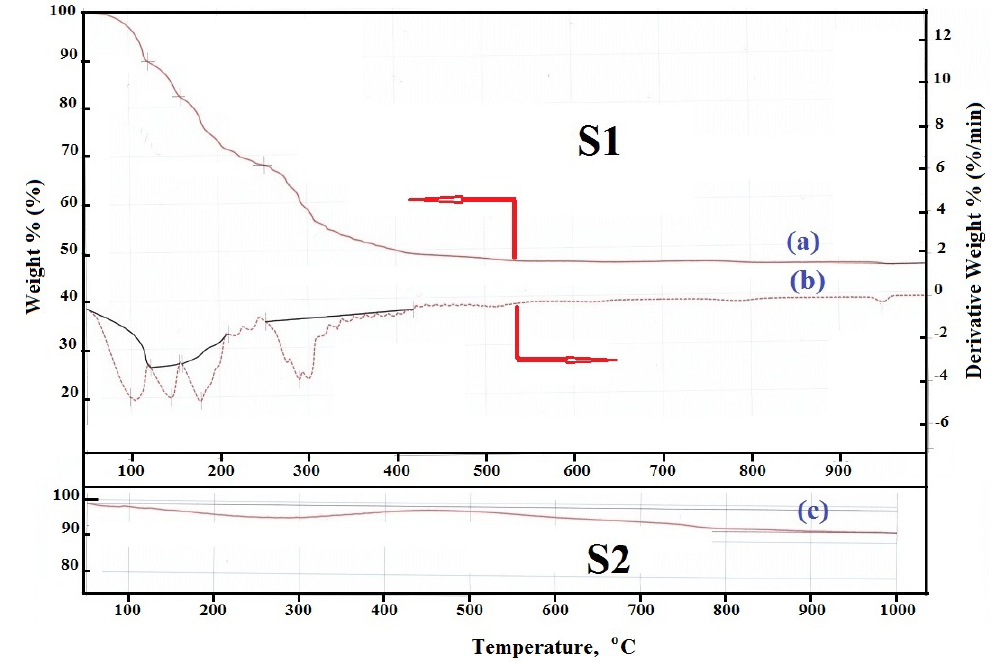
Figure 1. Thermal analysis of the prepared samples; ( a ) TG of S1, ( b ) DTG of S1 and ( c ) TG of